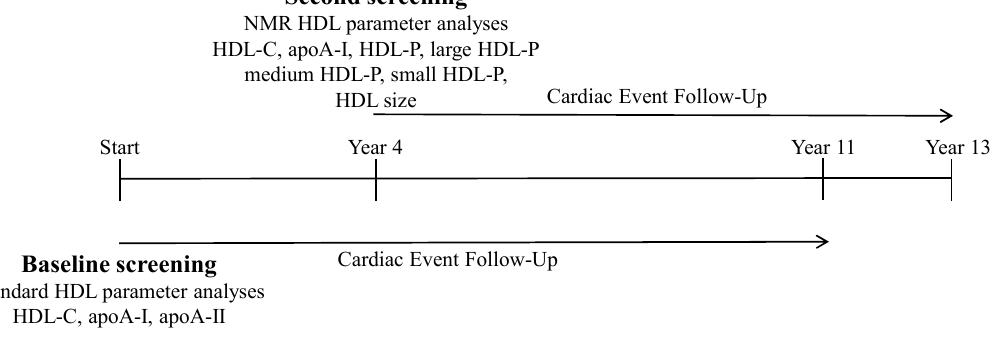
Figure 1. Overview of study design.